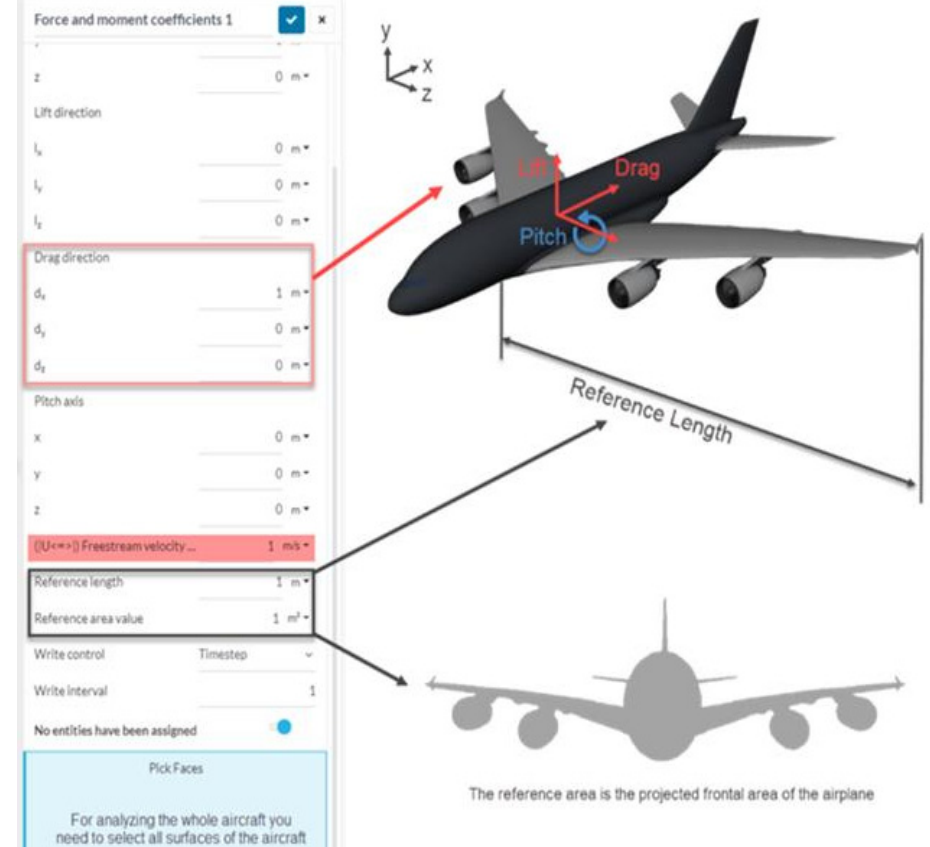
Figure 4. The reference area of the aircraft wings in SimScale platform.